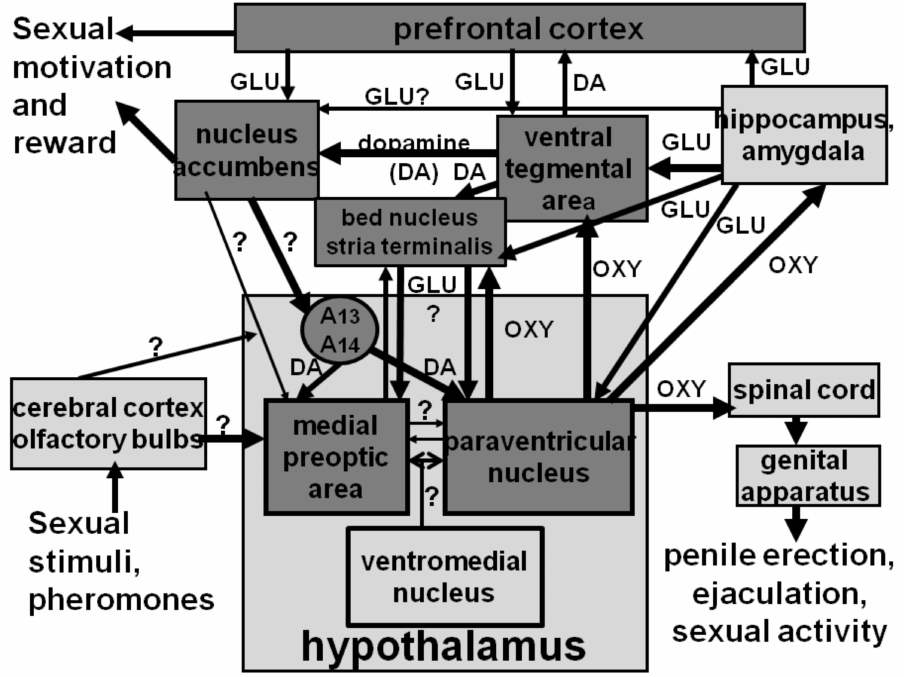
Figure 3. Dopamine participates in a complex central neural circuit that controls and influences sexual motivation and reward and copulatory performance at the central level together with other neurotransmitters and/or neuropeptides. This neural circuit interconnects the hypothalamus and its nuclei (paraventricular and ventromedial nuclei) with areas of the limbic system (ventral tegmental area, hippocampus, amygdala, bed nucleus of the stria terminalis), with the ventral medulla and the spinal cord. Among involved dopaminergic pathways are (i) incertohypothalamic dopaminergic neurons, which activate PVN oxytocinergic neurons that send their projections to the ventral medulla and spinal cord and to the ventral tegmental area, hippocampus, amygdala and bed nucleus of the stria terminalis; (ii) mesolimbic/and mesocortical dopaminergic neurons that originate in the ventral tegmental area that send projections to the nucleus accumbens, medial prefrontal cortex, bed nucleus of the stria terminalis and possibly to the hippocampus and amygdala. Together with glutamatergic neurons that interconnect the hippocampus and the amygdala with the ventral tegmental area, prefrontal cortex, bed nucleus of the stria terminalis, medial preoptic area and paraventricular nucleus, when this circuit is activated for instance by physiological stimuli (i.e., pheromones released by a sexually receptive female) or by drugs or peptides administered in one of the areas of the circuit (i.e., oxytocin injected into the ventral tegmental area, the hippocampal ventral subiculum or the amygdala), dopamine becomes active at different sites, i.e., in the paraventricular nucleus and the medial preoptic area, which are involved more in copulatory performance (penile erection and copulation), and in the nucleus accumbens in which dopamine plays a main role in sexual motivation, arousal and reward (heavy gray boxes indicate the brain areas of the circuit in which dopamine is involved/released). Thus, modifications in dopamine activity in these brain areas participate in the regulation of sexual motivation/arousal/reward and copulatory performance (erectile function/copulation) (for references see